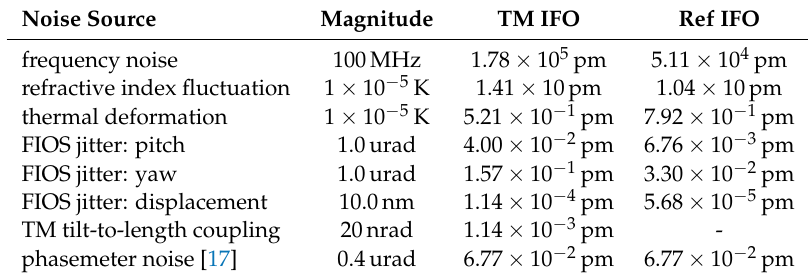
Table 2. Amplitude of the displacement noise of TM IFO and Ref IFO in a single optical head due to the main noise sources. The coefficient of thermal expansion and the dn / dT term of fused fused silica are taken to be 0.55 · 10 − 6 K − 1 , and 9.6 · 10 − 6 K − 1 ,